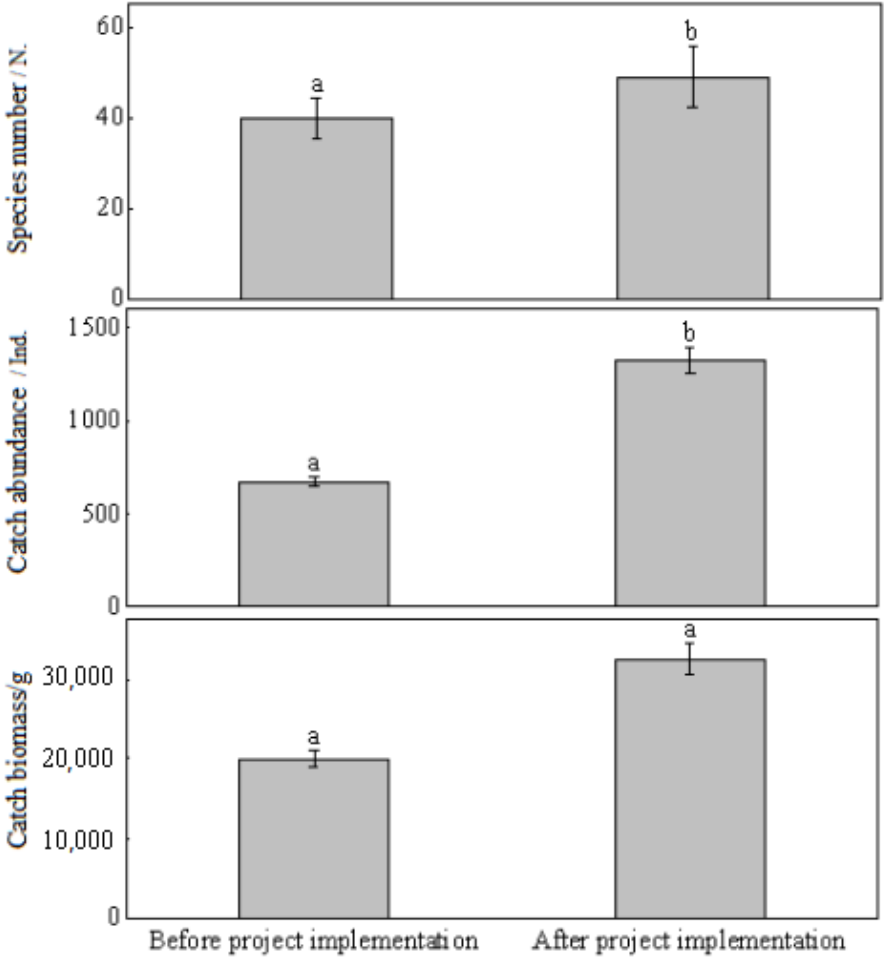
Figure 5. Changes in total species numbers, total fish abundance and total biomass before and after the implementation of the project. Error bars represent the standard deviation between all samples collected within a year before and after the project. To compare the fish resource variation, one-way ANOVA was conducted. The groups with significant differences ( p < 0.05) are represented by different lowercase letters (a, b), and those without significant differences are represented by the same lowercase letters.